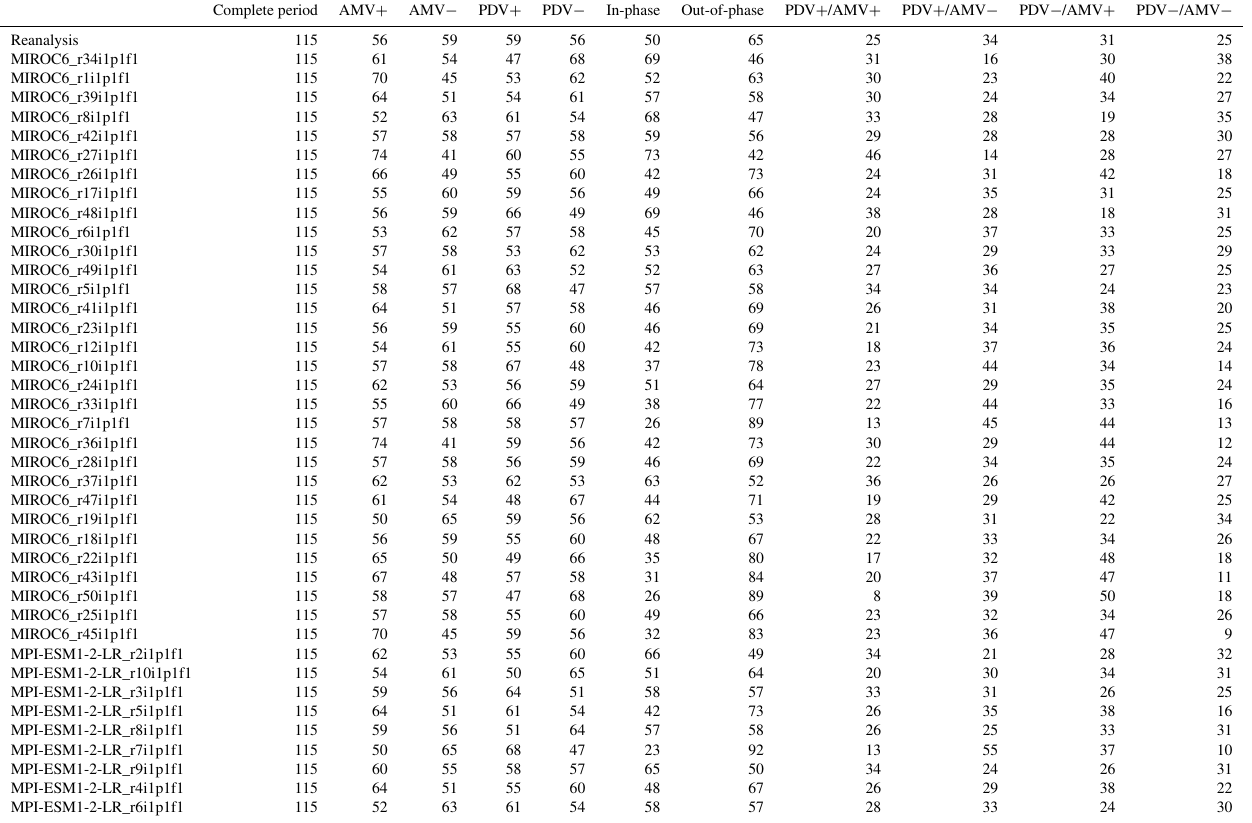
Table A9. Number of years for every regime for reanalysis and CMIP6 simulations